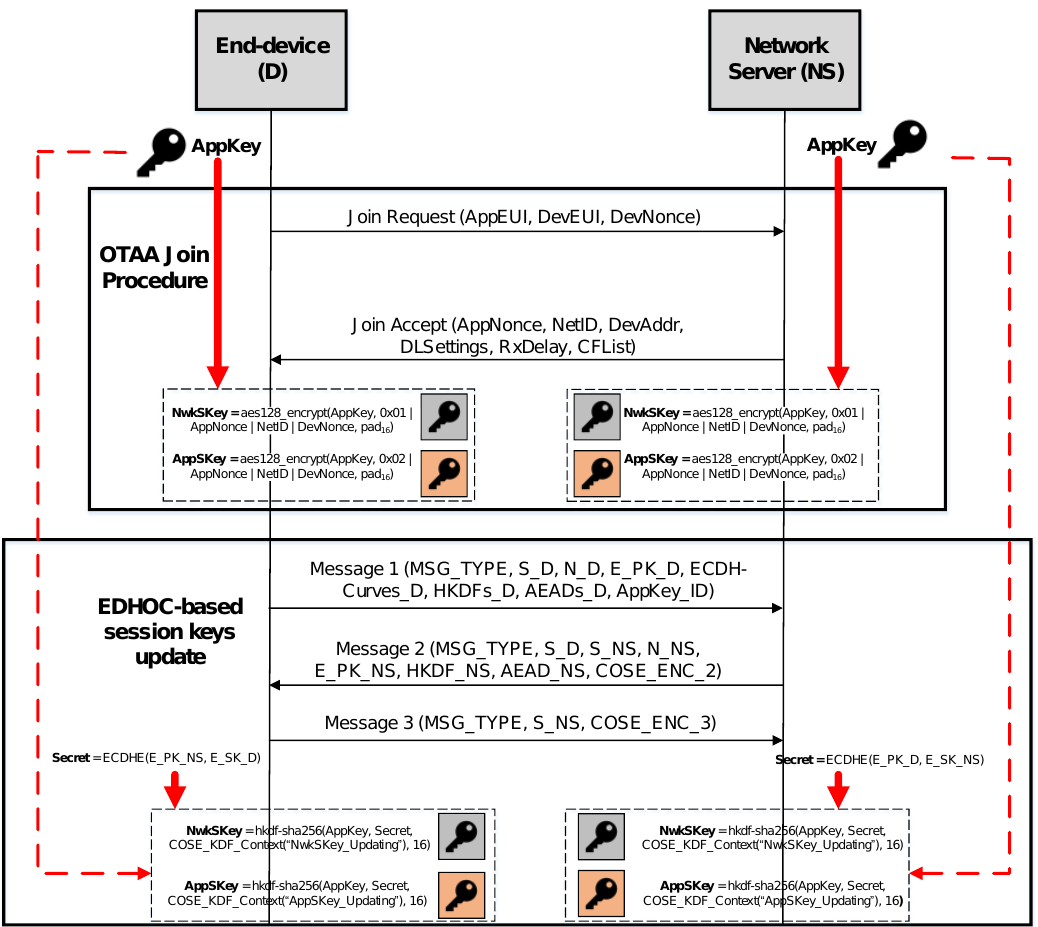
Figure 3. Overview of the EDHOC integration to enhance LoRaWAN key